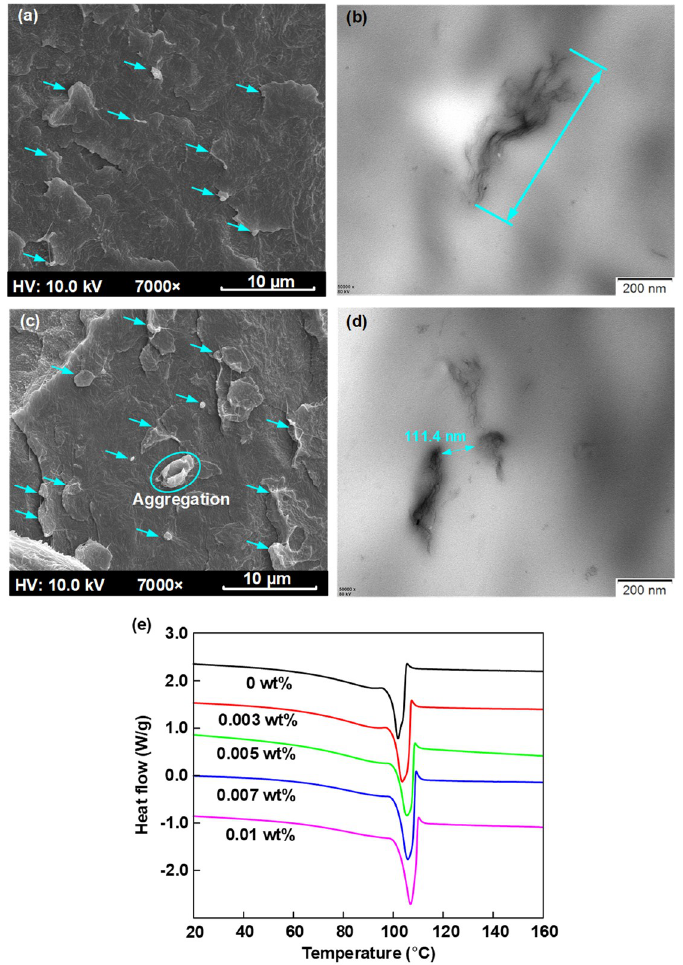
Figure 2. ( a , b ) SEM and TEM images of the cross section of the 0.005 wt % graphene/LDPE Nanocomposites. ( c , d ) SEM and TEM images of the freezing microtome section of the 0.01 wt % graphene/LDPE Nanocomposites ( e ) DSC curves of Nanocomposites as a function of graphene